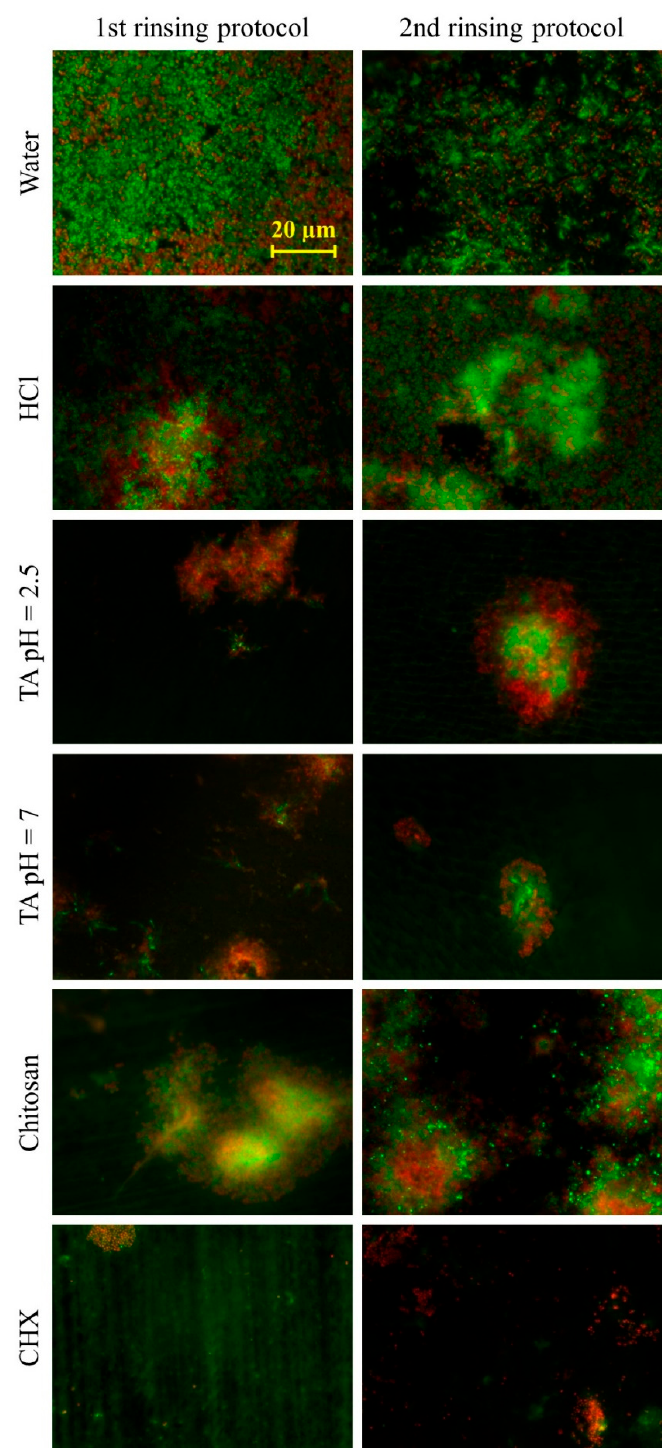
Figure 4. Representative LIVE/DEAD® BacLight™ images. During two days of biofilm formation on bovine enamel specimens in situ, subjects rinsed 4 or 5 times with different experimental solutions. By using two different rinsing protocols, the immediate and long-lasting effects were tested. For the ex-vivo examination with a fluorescence microscope, the biofilm was stained with LIVE/DEAD ® BacLight™. Living bacteria are fluorescent green, and dead bacteria are fluorescent red. HCl = hydrochloric acid, TA 2.5 = tannic acid (pH = 2.5), TA 7 = tannic acid (pH = 7) and CHX = chlorhexidine.